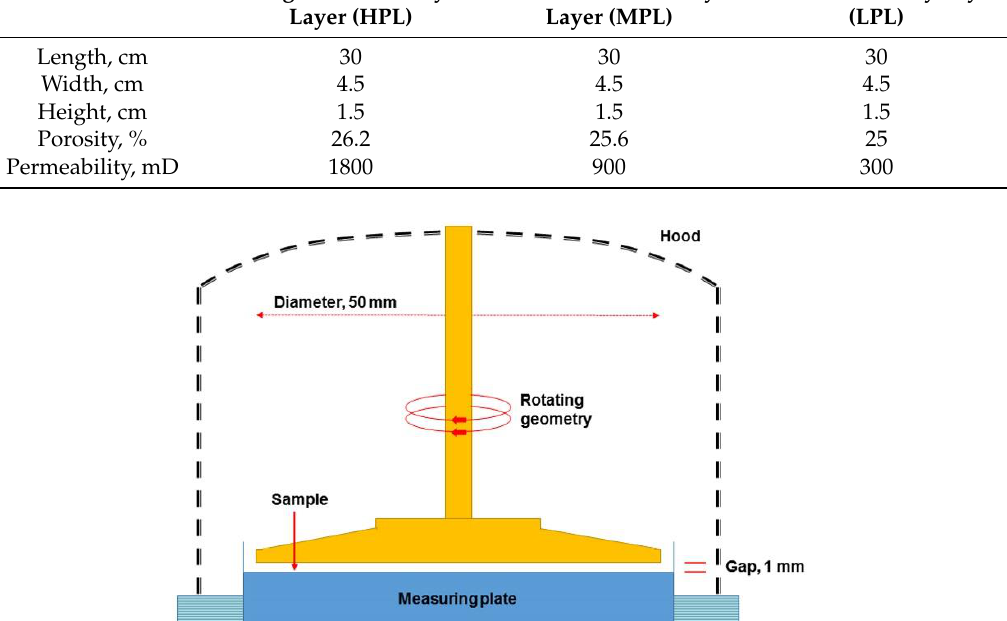
Figure 1. Schematic diagram of the rheometer with parallel-plate geometry.